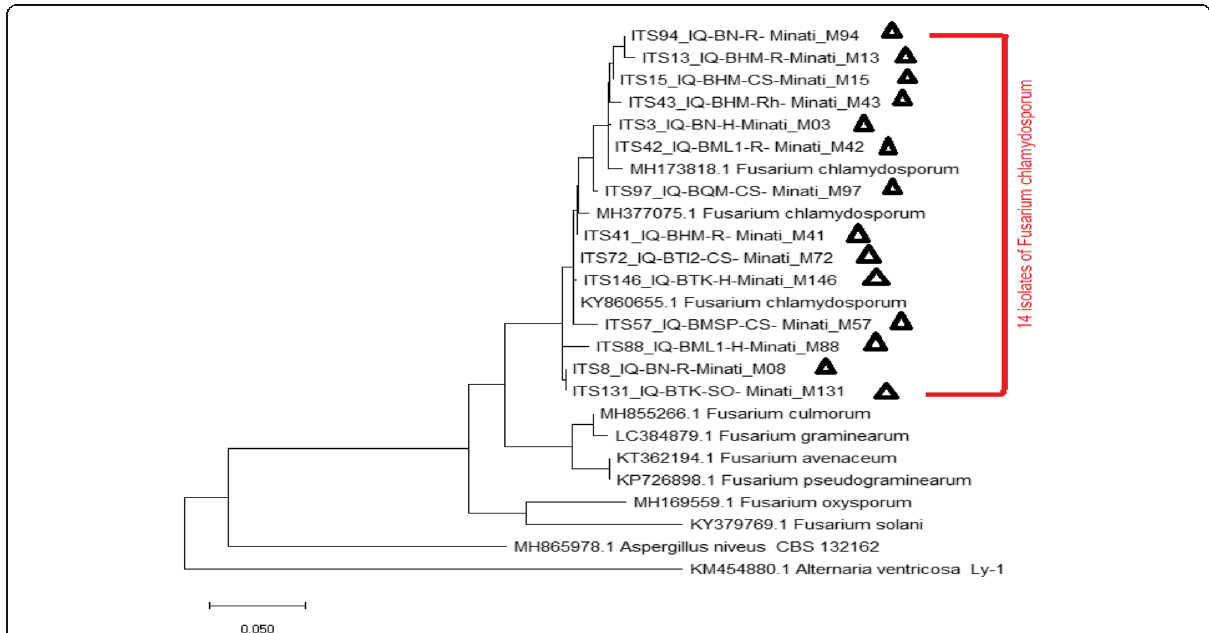
Fig. 4 Phylogenetic tree generated with the ITS-rDNA sequences of the Fusarium chlamydosporum (14), as inferred from the maximum likelihood (ML) analyses (determined by black triangles) and related species retrieved from GenBank. ITS sequences of Aspergillus niveus (MH865978) and Alternaria ventricosa (KM454880) were used as the out-group